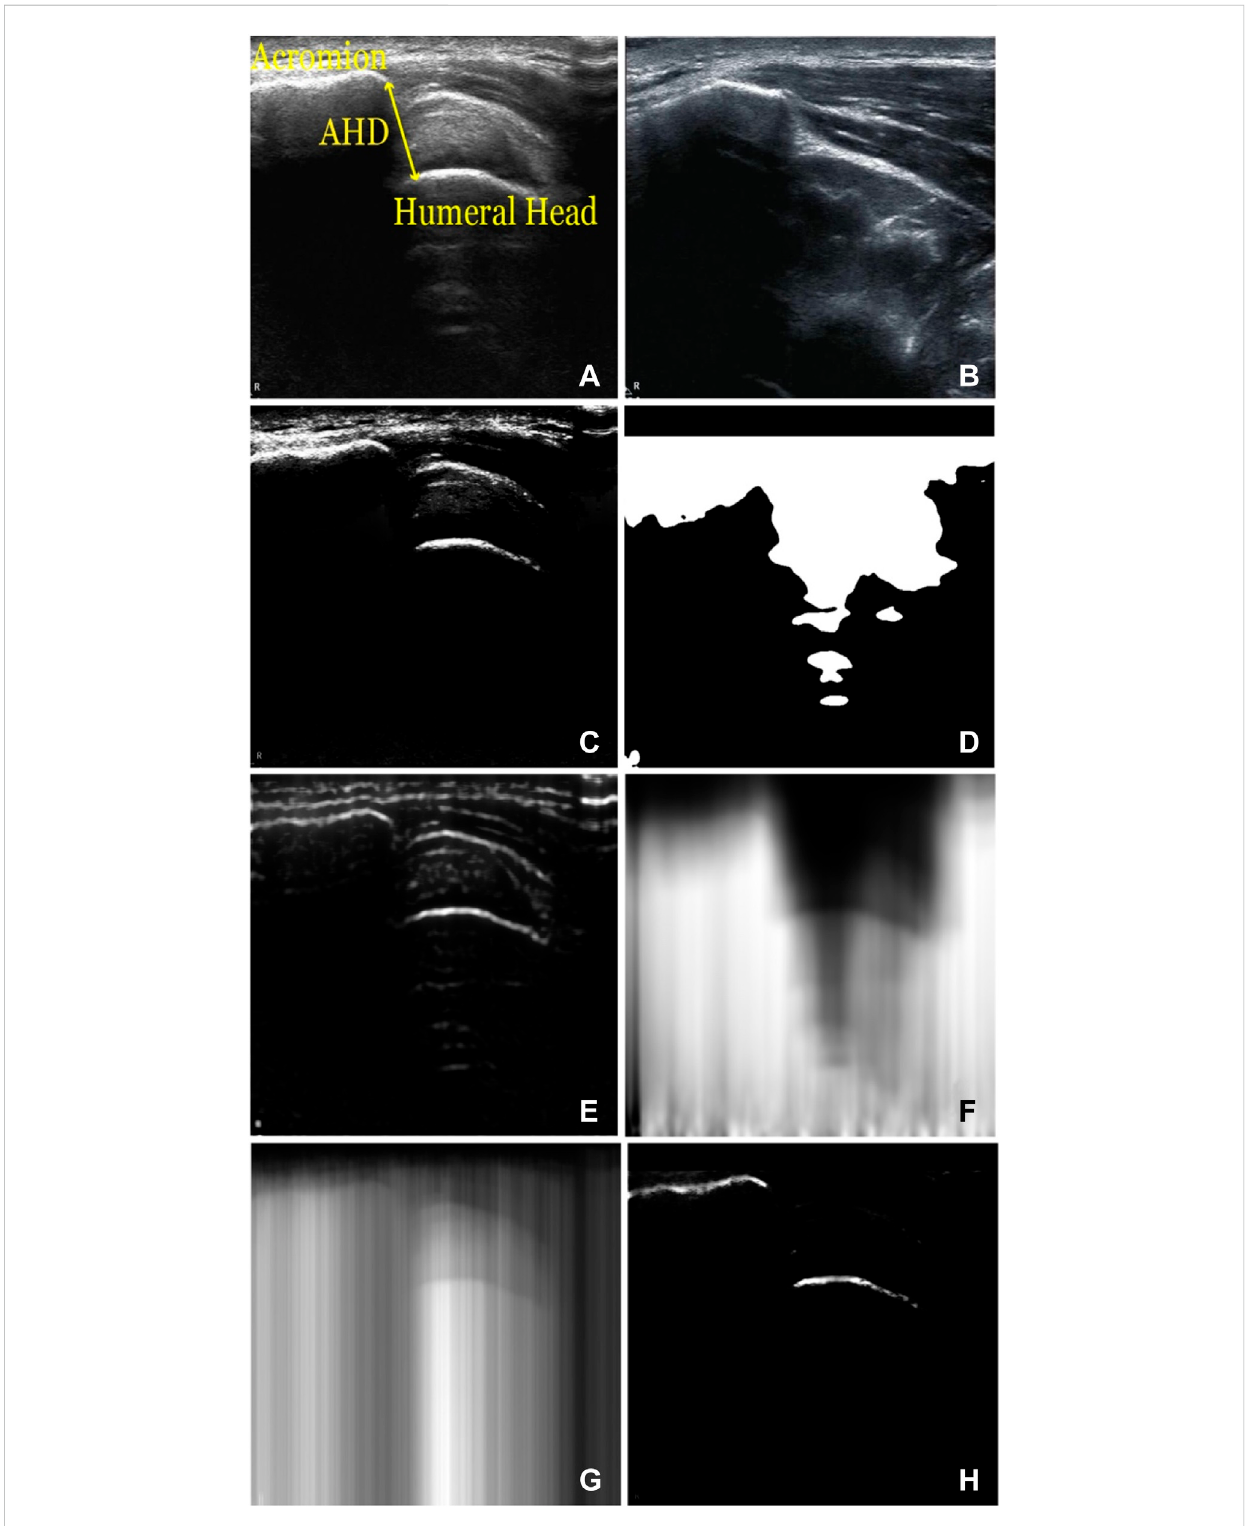
FIGURE 2 CAQUSAPipeline-postimagingprocess. (A) exampleUSimagewithAHDmeasurement (B) exampleofinadequateUSimage (C) USimagewithLog- Gabor fi lter applied. (D) Binary features (E) Laplacian of Gaussian with Gaussian Kernel (F) shadowed US image (G) integrated backscattering (H) example probability